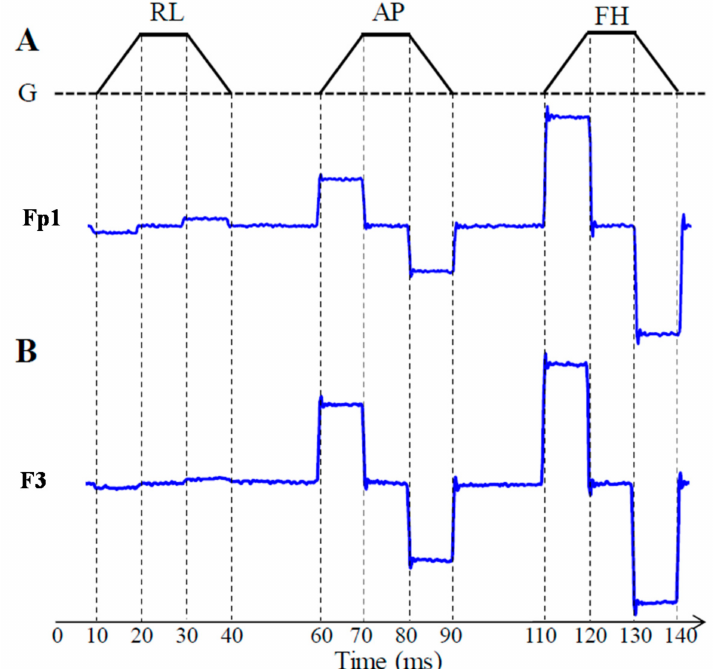
Figure 6. Representation of the three gradient pulses which were applied along the three orthogonal directions (right–left, RL, anterior–posterior, AP, and foot–head, FH) ( A ) and the corresponding induced artefact voltages (in µ V) in two example leads (Fp1 and F3) for the head-shaped phantom ( B